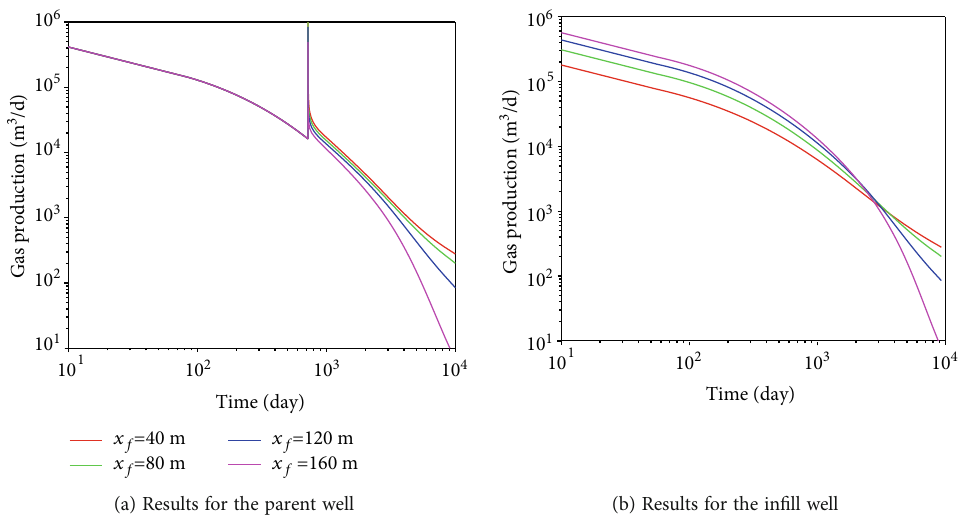
Figure 7: The e ff ects of the unconnected fracture length on the gas production of both parent and in fi ll wells.